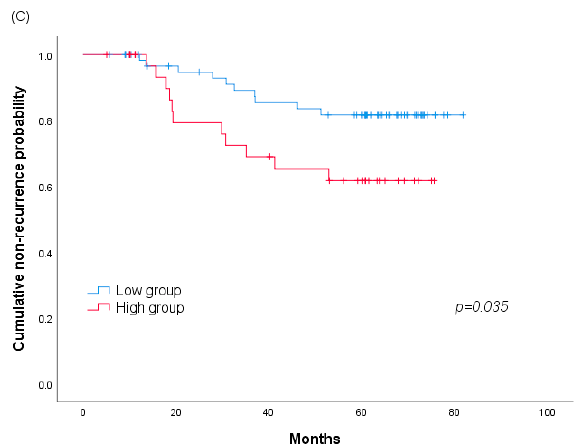
Figure 2. Kaplan–Meier analysis of the 60-months cumulative non-recurrence probability between the high and low groups according to the serum GPx3 change values ( A ) at 3, ( B ) 6 and ( C ) 12 months. Abbreviation: GPx3, glutathione peroxidase 3.